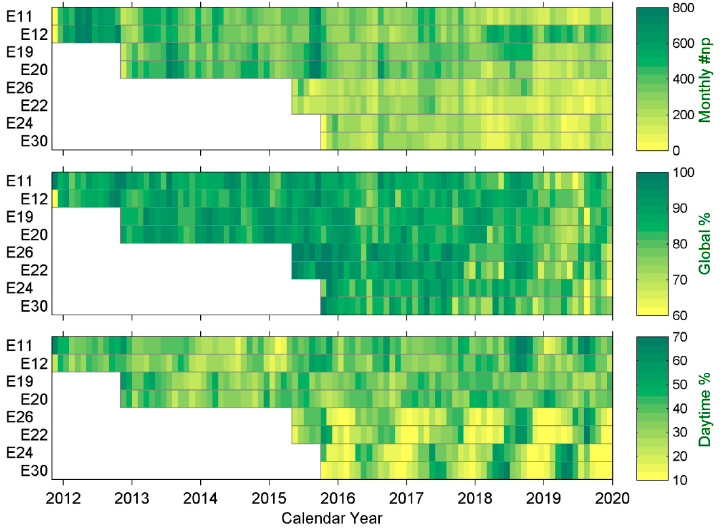
Figure 4. Number of monthly SLR normal points (np), their proportion in global observations, and the proportion of daytime observations at selected sites. Table 4. Statistical SLR tracking information for Galileo satellites, as of 31 December 2019. Each column of the table represented the satellite PRN, duration of SLR observation, total number of normal points for all sites, proportion of selected site observations, monthly average of selected site observations, and proportion of daytime observations at selected sites.